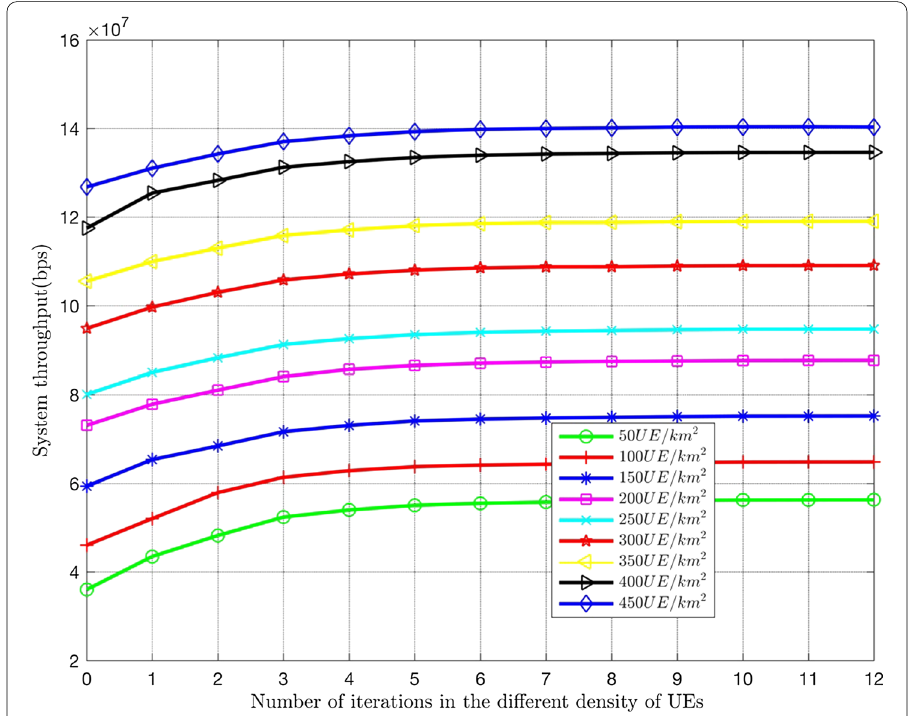
Fig. 13 The system throughput evolution in different density of